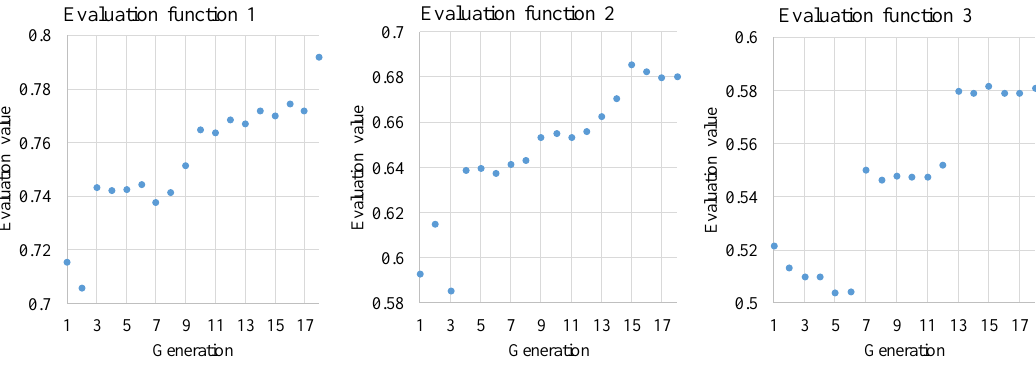
Figure 14. Evaluation value of each experiment (without load).